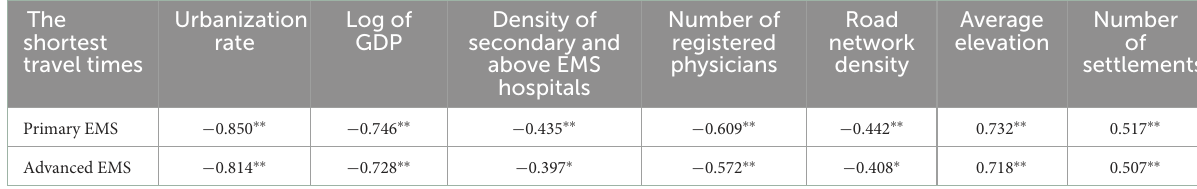
TABLE 7 Pearson’s correlation results of shortest travel times for primary and advanced emergency medical services (EMS). The shortest travel times